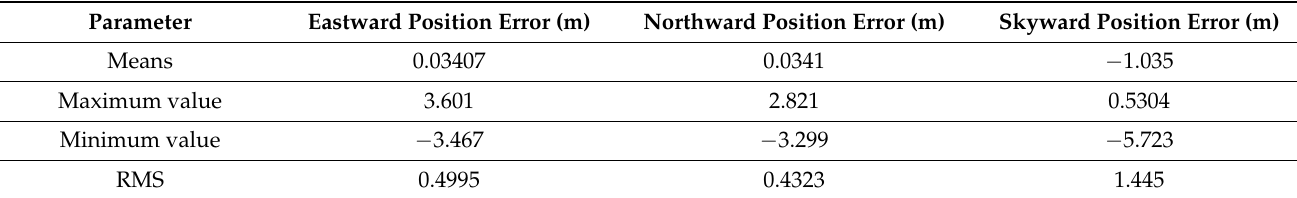
Table 4. Flight test position error.